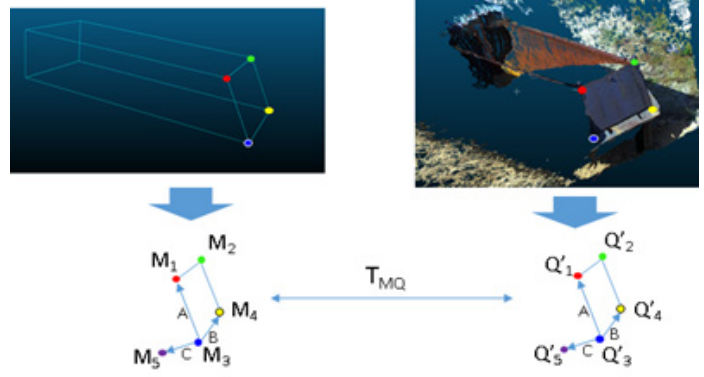
Figure 13. A method to match the plane between two models.